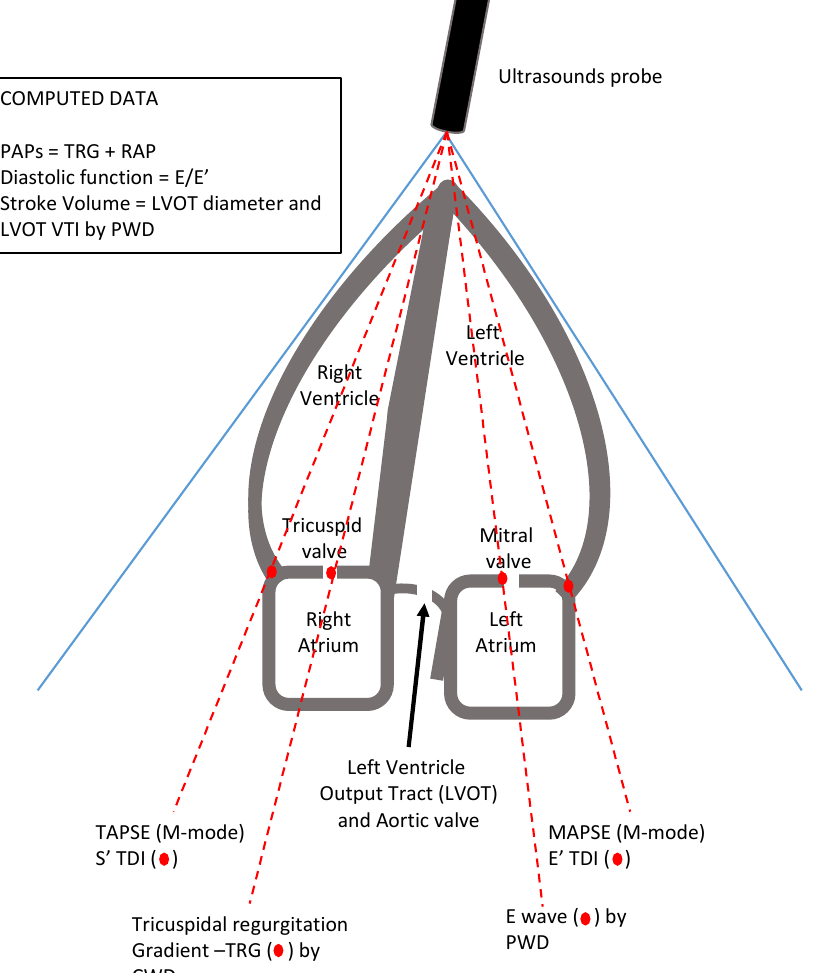
Figure 2. The apical-4/5-chamber views. The red points indicate where the focus of the Doppler must be placed. Abbreviations: CWD, Continuous Wave Doppler; LVOT, left ventricle output tract; MAPSE, mitral annular plane systolic excursion; TAPSE, tricuspid annular plane systolic excursion; TDI, tissue Doppler imaging; TRG, Tricuspidal Regurgitation Gradient; PWD, Pulse Wave Doppler; RAP, right atrial pressure; VTI, Velocity Time Integral.